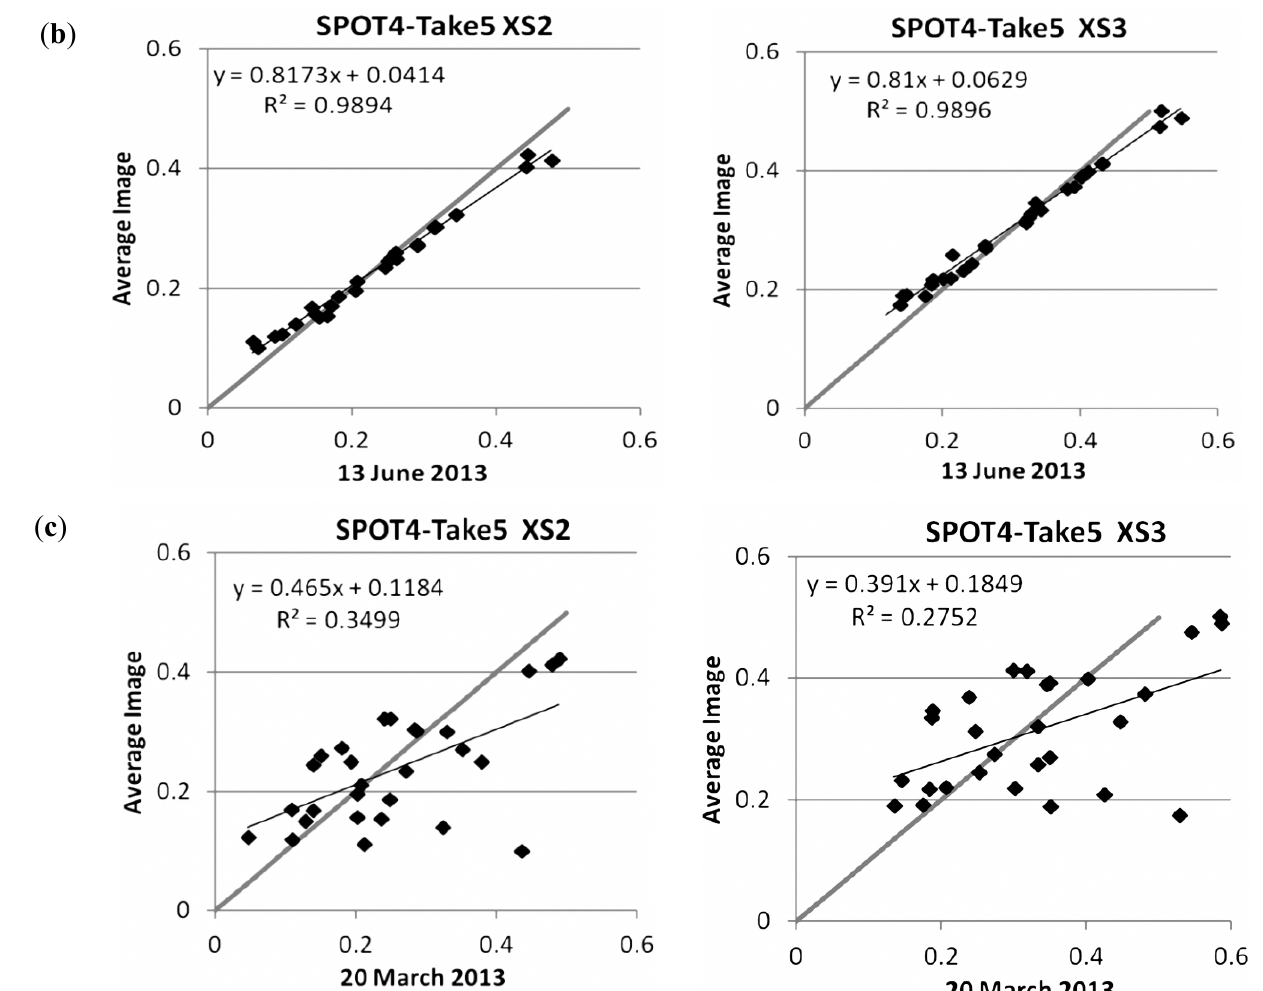
Figure 4. Comparison between the SPOT4-Take5 atmospherically corrected images and the average SPOT4 reflectance for the 28 invariant sites, for spectral bands XS2 and XS3. Example of ( a ) an image for which no additional correction is required, ( b ) an image needing an additional correction and ( c ) a hazy image (discarded from the final time